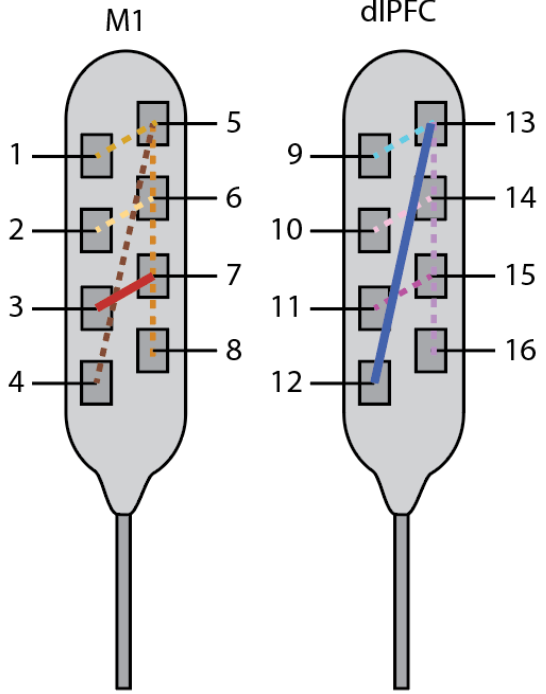
Figure 2. Day 1 and 2: parameter sweep over bipolar pairs (lines) for choice of stimulating contacts. Preferred stimulation electrodes were 3 and 7 for M1 (red solid line), and 12 and 13 for dlPFC (dark-blue solid line).